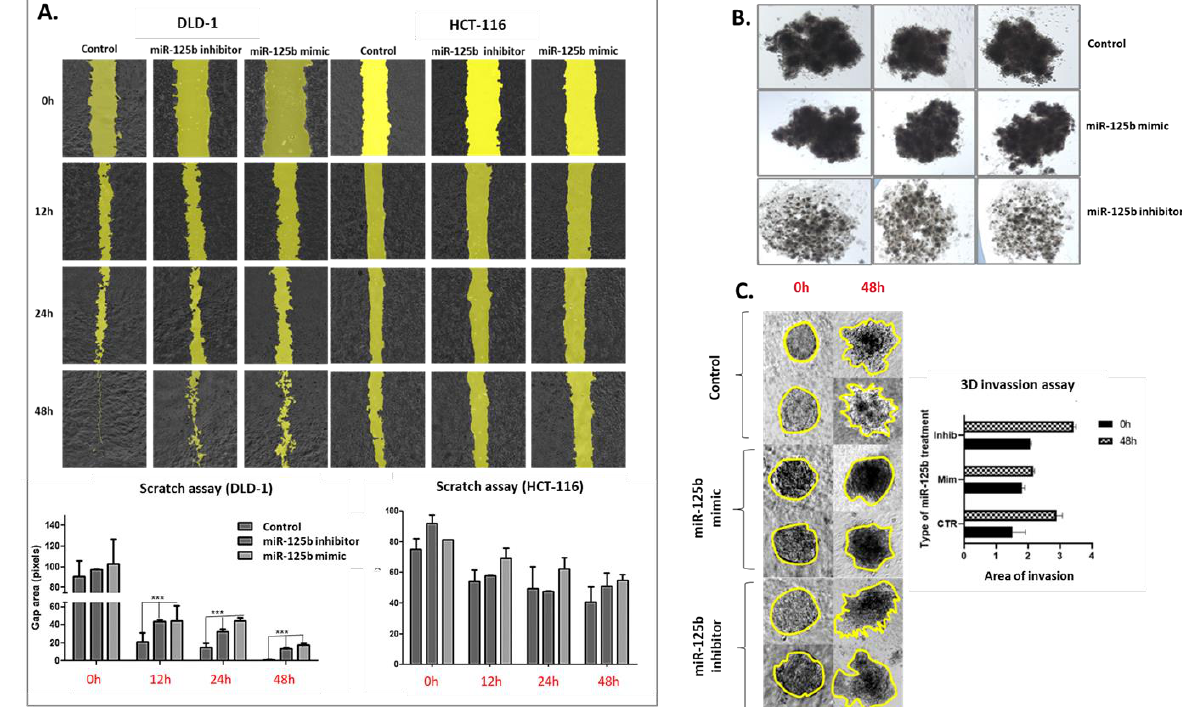
Figure 6. The effects of miR-125b replacement/inhibition on colon cancer cell invasion/migration. ( A ) Wound healing assay results of DLD-1 and HCT-116 cells control or treated with miR-125b mimic/inhibitor (100 nM): top—pictures of scratch closing through 48 h (0 h, 12 h, 24 h, and 48 h) processed with the help of Image J software; bottom—graphical representation of the gap site for the two cell lines in each of the experimental conditions at 0 h, 12 h, 24 h, and 48 h timepoints. Experiments were performed in biological duplicates for each cell line and each treatment scheme (data presented as mean ± S.D., *** p < 0.001 for DLD-1 at 12 h ANOVA test comparing control versus miR-125b mimic versus miR-125b inhibitor; *** p < 0.001 for DLD-1 at 24 h ANOVA test comparing control versus miR-125b mimic versus miR-125b inhibitor; *** p < 0.001 for DLD-1 at 48 h ANOVA test comparing control versus miR-125b mimic versus miR-125b inhibitor. ( B ) Aspect of spheroids of DLD-1 cell treated with miR-125b mimic (100 nM) or miR-125b inhibitor (100 nM). The representative pictures were taken with an inverse optical microscope at 4× magnification. ( C ) Pictures and graphical representation of the 3D invasion assay of the extracellular matrix of DLD-1 control, miR-125b mimic (100 nM) and miR-125b inhibitor (100 nM) spheroids. Area of spheroid is indicated by a yellow line. The graph contains the progression of the spheroid area. Experiments were performed in biological duplicates for each cell line and each treatment scheme (data presented as mean ± S.D.).